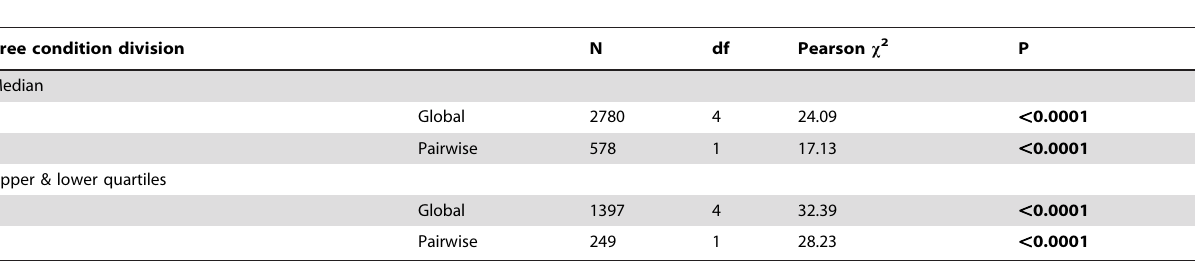
Table 3. Pearson Chi-squared